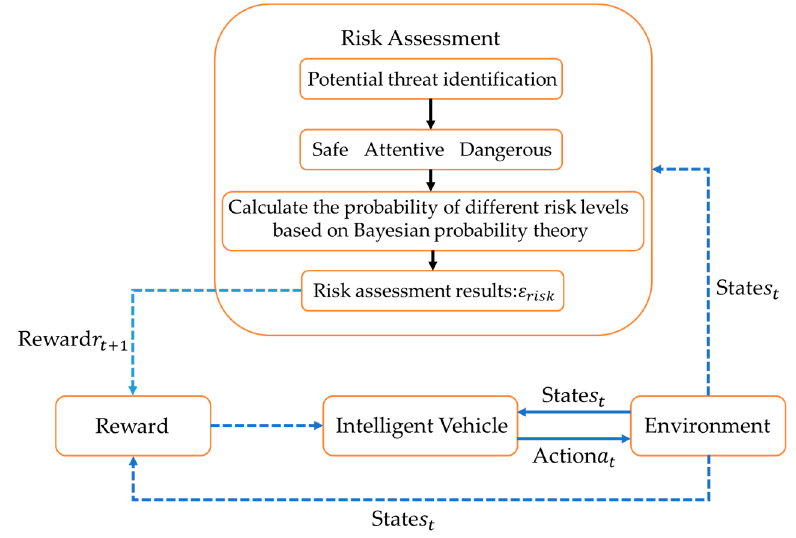
Figure 8. Intelligent driving decision algorithm